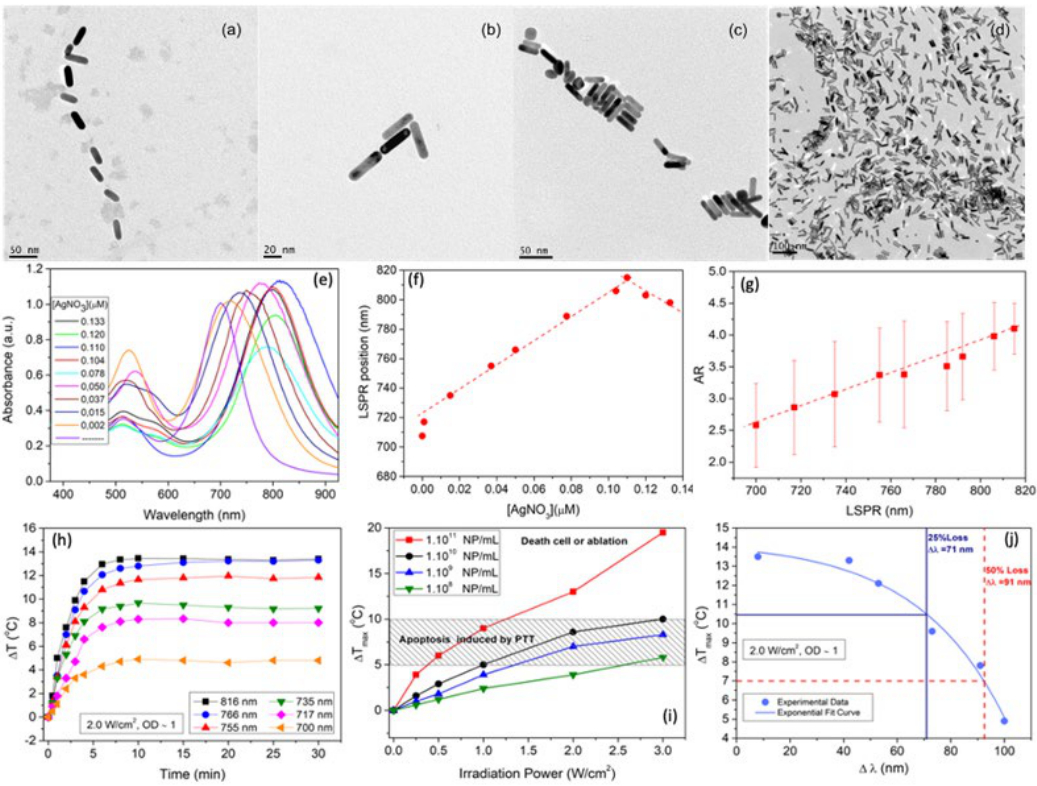
Figure 1. TEM images of synthesized AuNRs with dimensions: ( a ) 34 × 12, ( b ) 36 × 11, ( c ) 34 × 10, ( d ) 31 × 8 nm, obtained after the addition of 0.012, 0.043, 0.032 and 0.096 µ M of AgNO 3 to the Au-CTAB complex, respectively. Changes in ( e ) absorption spectrum; ( f ) LSPR maximum; and ( g ) AR of AuNRs upon changes in AgNO 3 concentration during colloidal synthesis. Dashed lines are only to guide the eye. In ( e ), the two classical extinction peaks are observed: the transverse LSPR shows little changes with AuNR AR (ca. 510 nm), whilst the longitudinal one markedly redshifts as the particle AR increases (from 700 to 816 nm). ( h ) Temperature increments ( ∆ T ) for AuNRs with LSPRs located at ( (cid:4) ) 816 nm, [33.1 × 8.1 nm], ( • ) 766 nm [36.6 × 11.1 nm], ( (cid:78) ) 755 nm [34.0 × 10.2 nm], ( ) 735 nm [30.2 × 10.1 nm], ( ) 717 nm [33.5 × 11.9 nm] and ( ) 700 nm [34.4 × 12.4 nm] using a CW laser source of 808 nm at 2.0 W/cm 2 . ( i ) Solution temperature dependence of CTAB-coated AuNRs with a LSPR band centered at 802 nm at different particle concentrations under NIR illumination (808 nm, 30 min) of different intensities. ( j ) AuNRs efficiency loss as a function of the LSPR-resonance shift. This shift was calculated as Δλ = │ λ laser − λ SPRL │ .